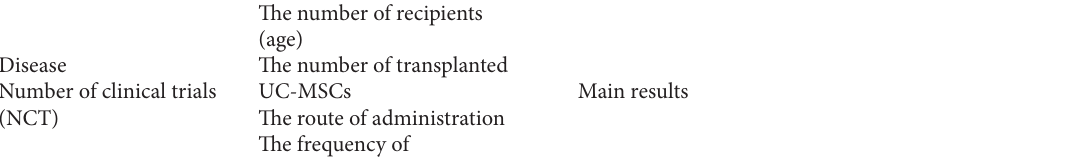
Table 6: Clinical studies regarding the use of